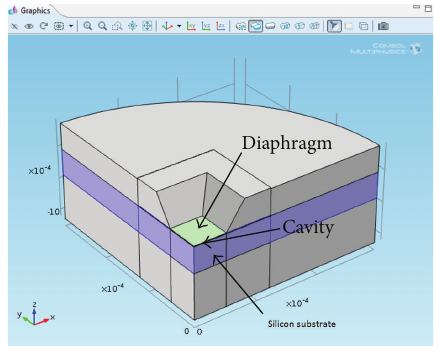
Figure 1: Modeling of 3D MEMS capacitive pressure sensor.